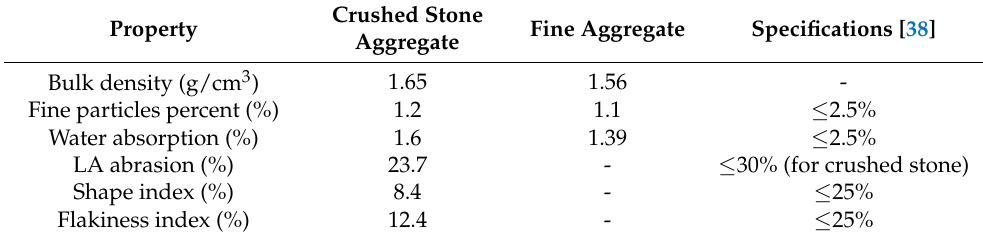
Table 2. Properties of